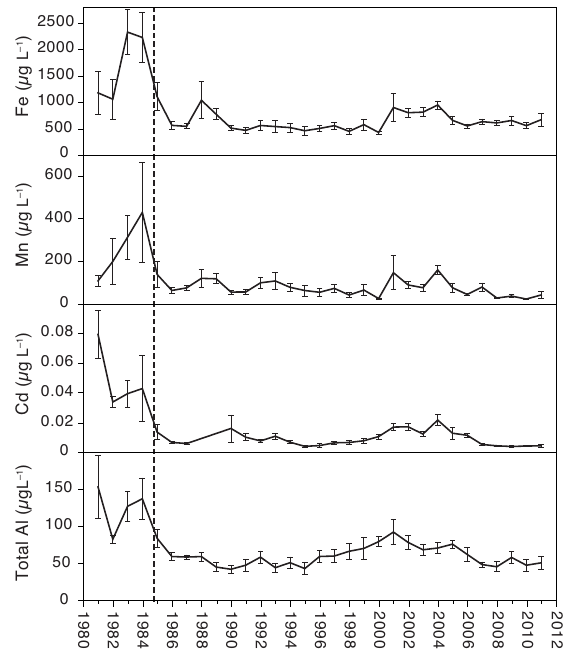
Fig. 7. Concentrations (annual means, ± SD) of Fe, Mn, Cd, and Al in R. Djursvasslan (5004) and its two tributaries (5002, 5003) before and after the start of liming, indicated by the vertical dashed